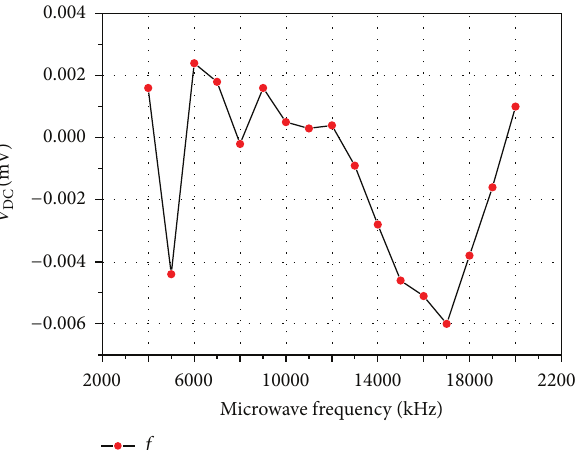
Figure 5: AC- to -DC conversion in NG film.